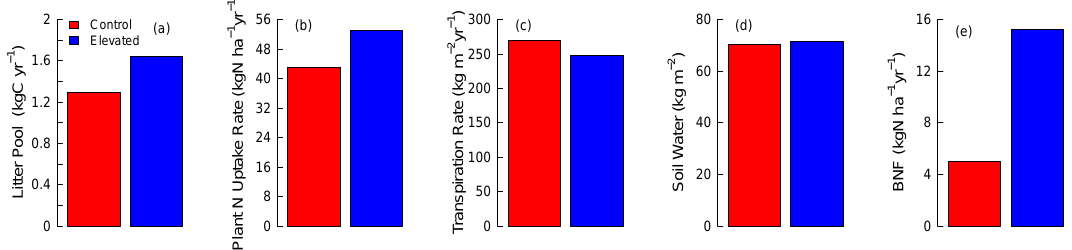
Figure 9. CO 2 fertilization effects (no temperature change) on litter pool size (Panel a ), plant nitrogen uptake rate (Panel b ), canopy transpi- ration rate (Panel c ), soil water content in the root zone (Panel d ) and biological nitrogen fixation (BNF) rate (Panel e ). Shown is the 100-year average of global means (spatial) for control (284ppm, red) and with elevated CO 2 (568ppm, blue).